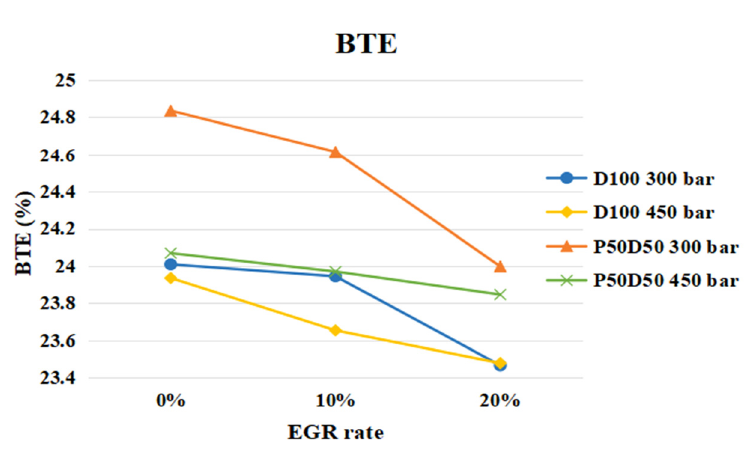
Figure 11. BSFC under different EGR rates at 300 and 450 bar.